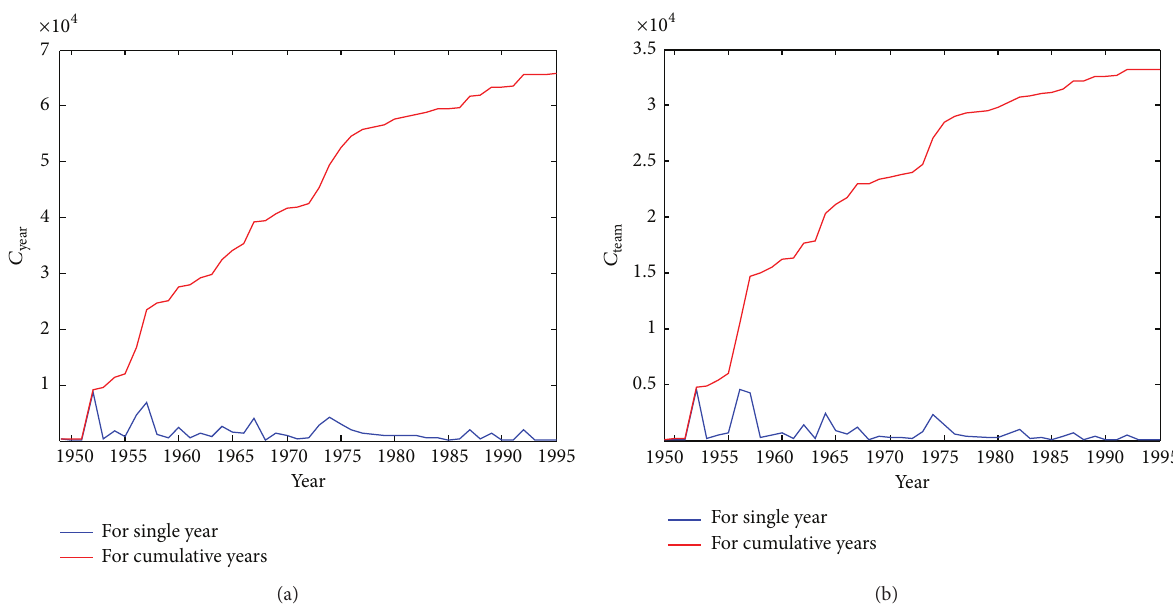
Figure 7: Comparison of the cumulative creative ability with single year creative ability. (a) For TD Lee; (b) For his